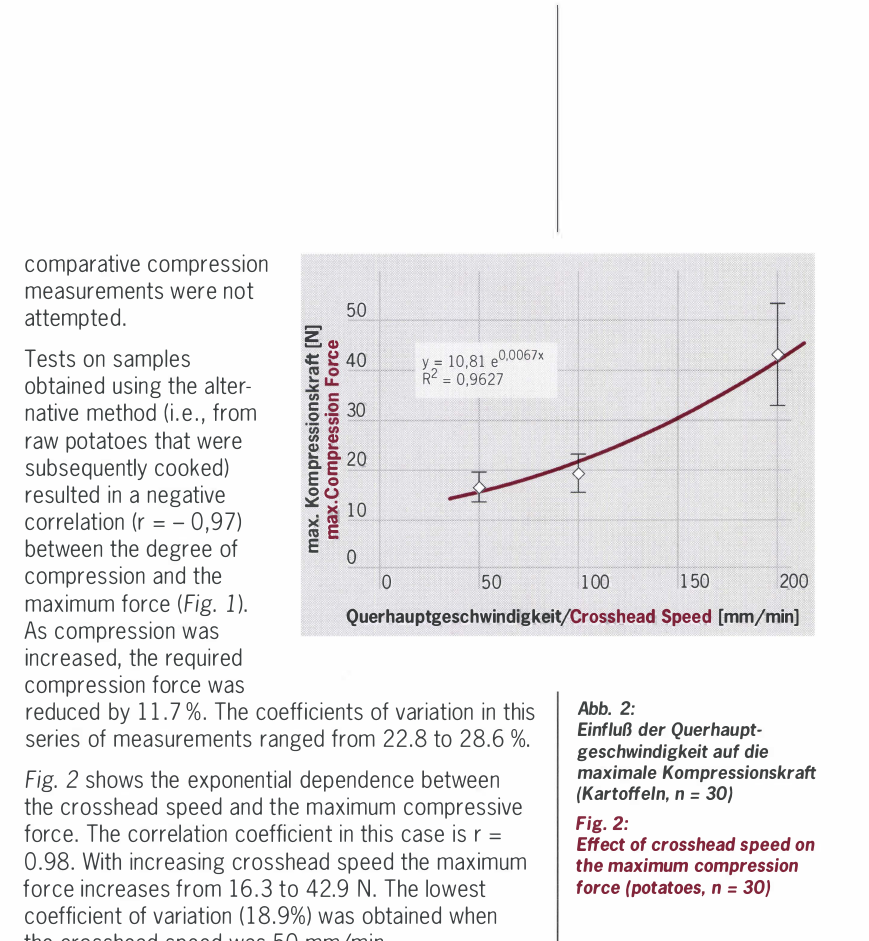
Fig. 2: Effect of crosshead speed on the maximum compression force (potatoes, n =